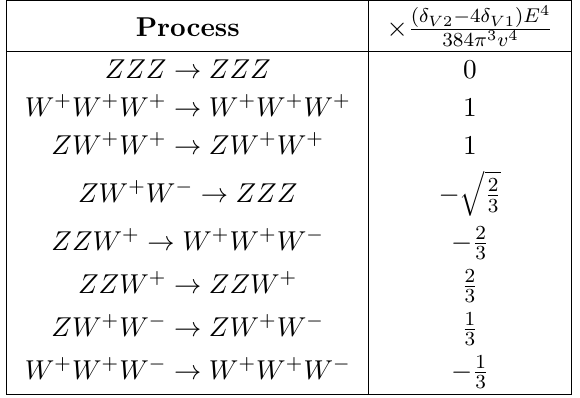
Table 4 . 6-body unitarity-violating processes that depend on δ V 2 and δ V 1 . One can see that the dim-6 SMEFT prediction δ = 4 δ gives vanishing amplitudes for all processes. V 2 V 1